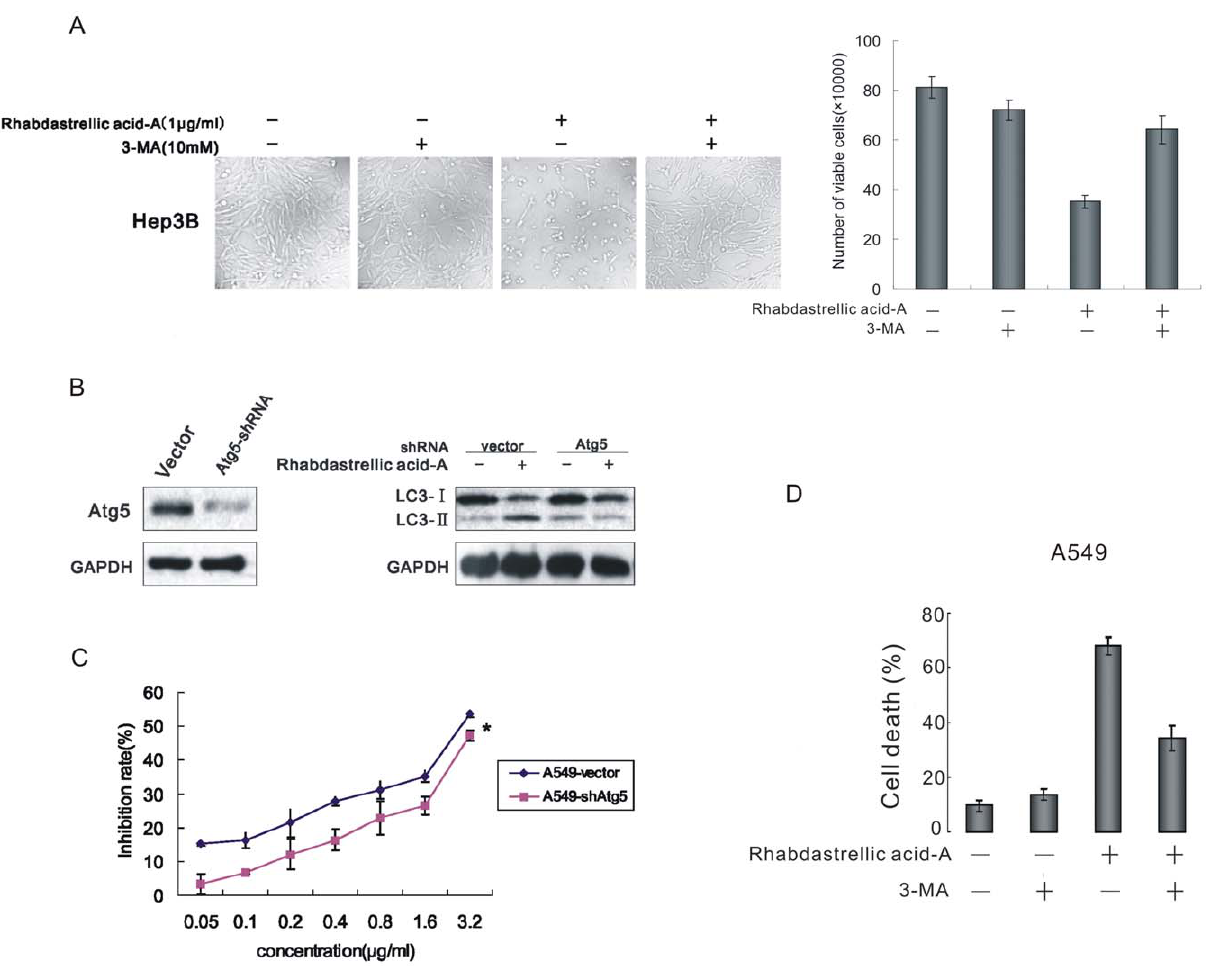
Figure 5. Requirement of autophagy induction for Rhabdastrellic acid-A-induced cell death. A. Hep3B cells were treated with 1 m g/mL Rhabdastrellic acid-A and/or 10 mM 3-MA for 36 h, and then examined by inverted microscope. *, p , 0.05 vs. Rhabdastrellic acid-A 2 /3-MA-. **, p , 0.05 vs. Rhabdastrellic acid-A + /3-MA-. B. Lysates from A549-Vector and A549-shAtg5 cells were analyzed by immunoblotting with Atg5 and LC3 antibodies. C. A549 vector cells and A549-shAtg5 cells were cultured at 6000 cells per well in a 96-well plate, exposed to different concentrations of Rhabdastrellic acid-A from 0.05 to 3.2 m g/mL for 72 h. The growth inhibition was detected using MTT assay. Reported values are mean 6 SD of triplicate samples from a representative experiment. *P-vlaue , 0.05 as compared with cells treated in the same way, but transfected without shRNA. D. A549 Cells were incubated with 4 m g/mL Rhabdastrellic acid-A and/or 10 mM 3-MA for 24 h. Cell death was quantified using flow cytometry as PI staining assay. The experiment was repeated 3